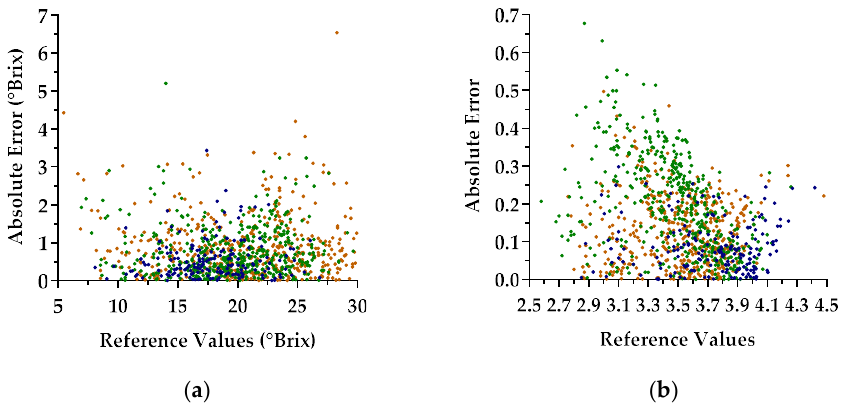
Figure A2. Boxplot of the descriptive statistics for pH reference values used for the training process and independent test phases. The boxes represent the 25th, 50th and 75th percentiles, the whiskers represent the fifth and 95th percentiles, the lower and upper open circles represent the minimum and maximum values, and the plus symbol denotes the mean values.